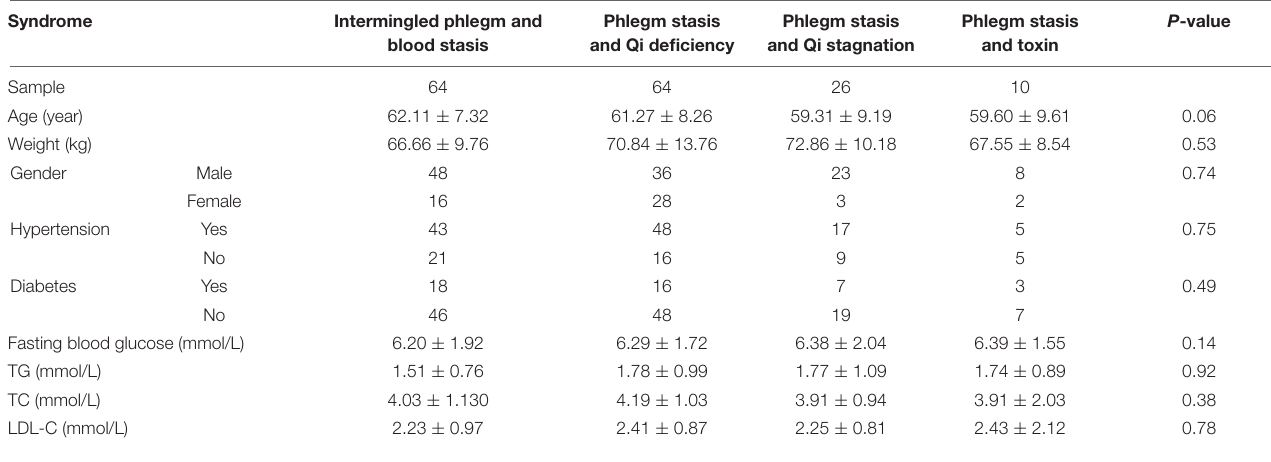
TABLE 1 | Characteristics of included